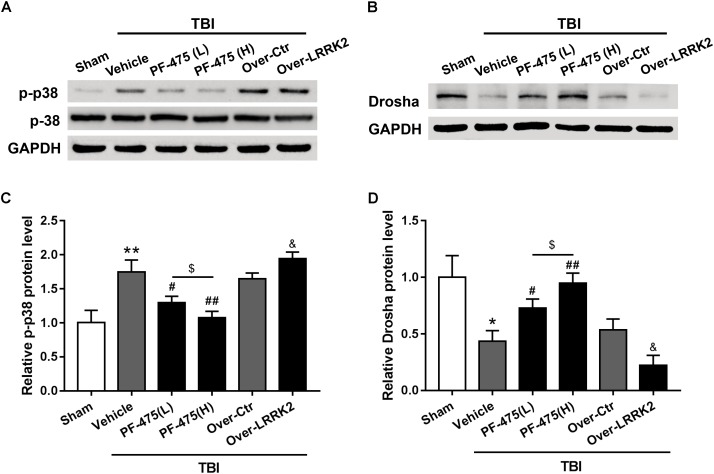
Effects of LRRK2 intervention on the p-p38 and Drosha protein levels after TBI. Western blot analysis was conducted to assess the (A) p-p38 and (B) Drosha protein levels after LRRK2 intervention. (C,D) The densities of the protein bands in the representative images were analyzed and normalized to GAPDH. The PF-475 treatment reversed the TBI-induced increase in p-p38 and decrease in Drosha expression, whereas LRRK2 overexpression augmented the TBI-induced changes in p-p38 and Drosha expression. Statistical analyses were performed using one-way ANOVA followed by Tukey’s post hoc test. Data are presented as the mean ± SD, n = 6 animals per group. ∗P < 0.05, ∗∗P < 0.01 vs. sham; #P < 0.05, ##P < 0.01 vs. the Vehicle group; &P < 0.05 vs. the Over-Ctr group; $P < 0.05 vs. the indicated group.